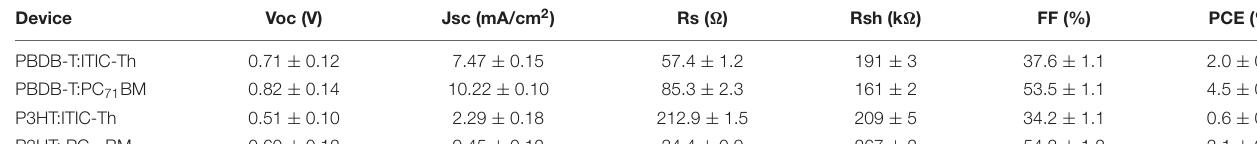
TABLE 1 | Performance characteristics of different devices.